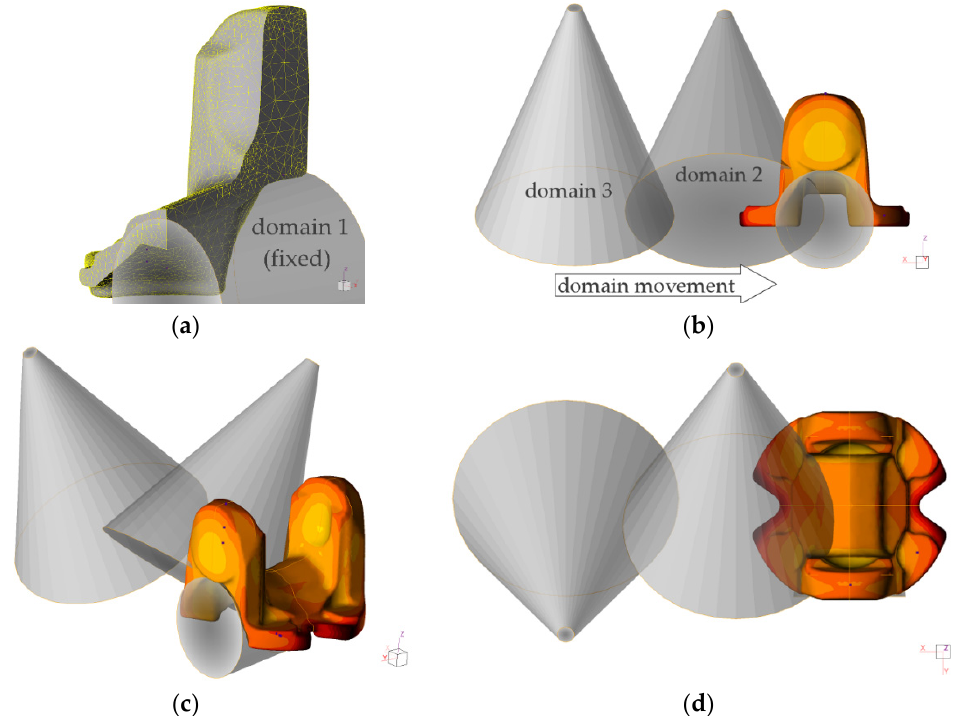
Figure 4. Numerical model of sprayer domains used in the simulation with definition of the estab- lished heat transfer coefficients (domains 2 and 3) and shadow area (domain 1), where: ( a ) numerical model of the forged part with tetrahedral mesh, ( b – d ) configuration of domains in front, isometric and top view,